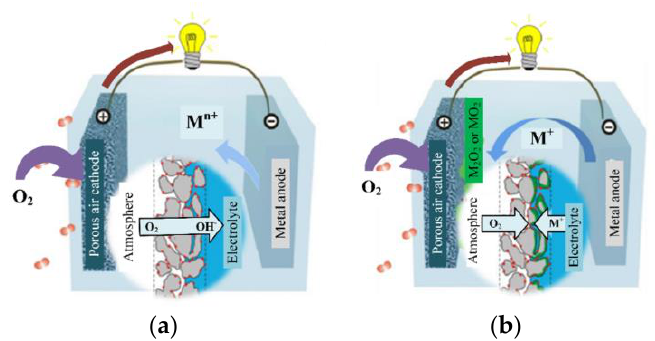
Figure 37. Schematic configuration and operation principle for (a) aqueous and (b) non-aqueous metal–air batteries. Inserts illustrate the oxygen reduction reaction taking place at the porous air cathode [116].